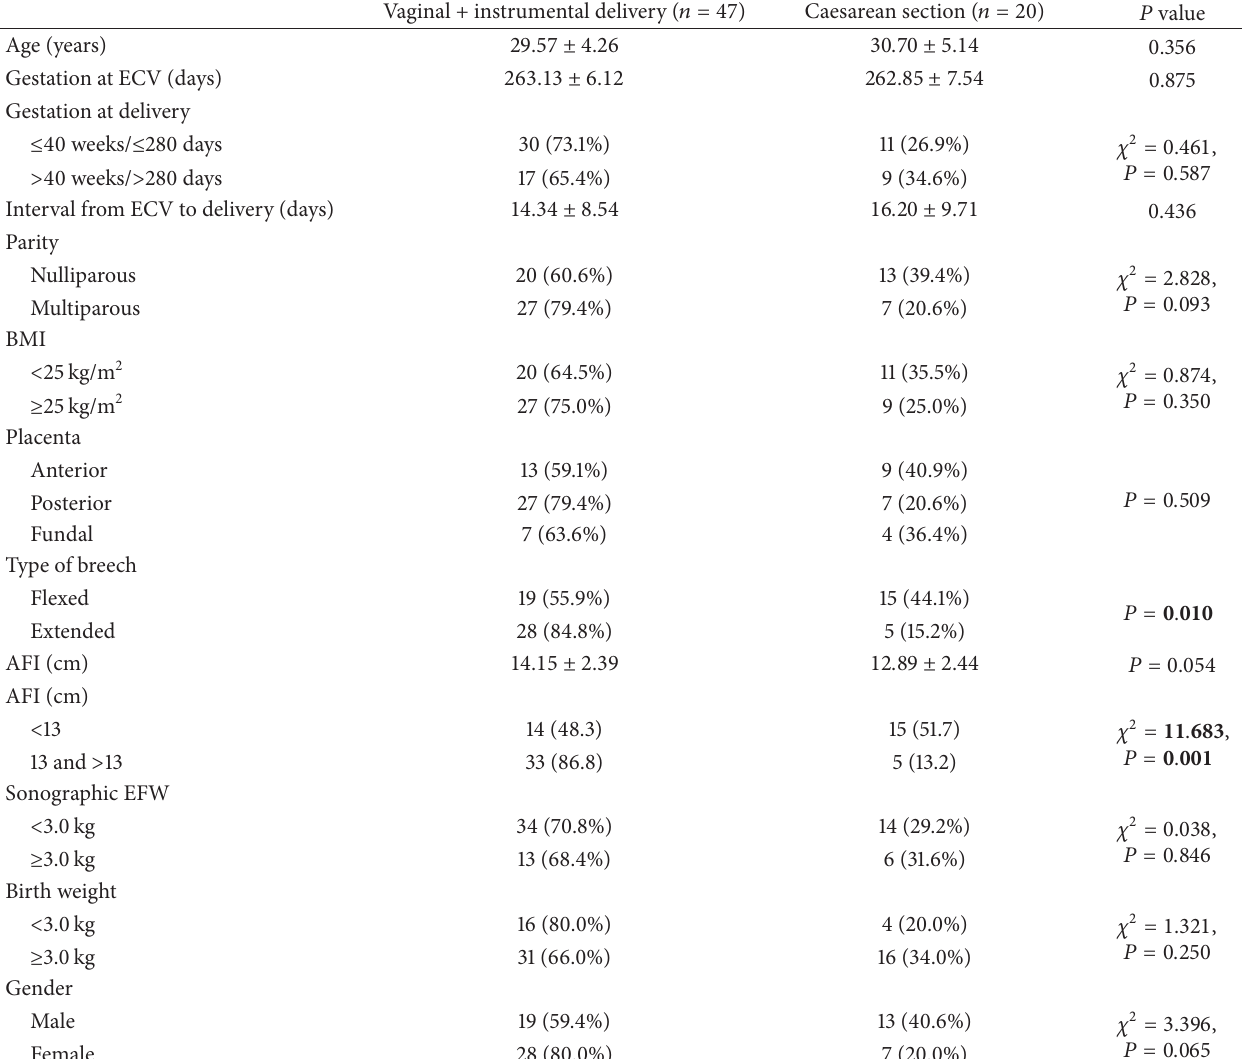
Table 6: Factors predicting successful vaginal delivery following successful external cephalic